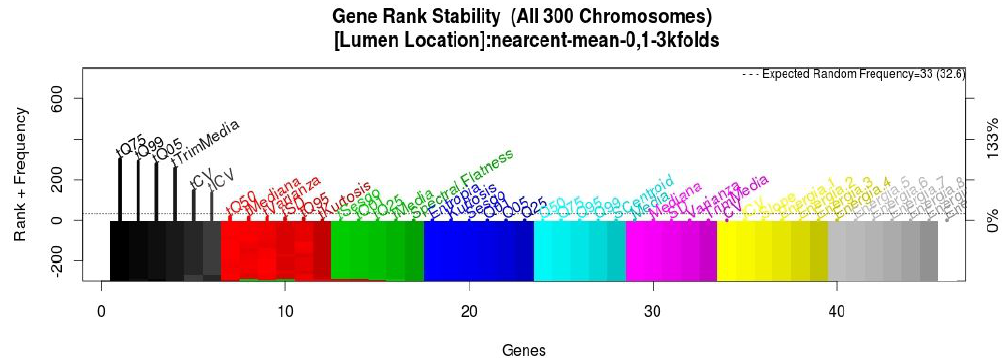
Figure 4. Light sensor summer dataset gene